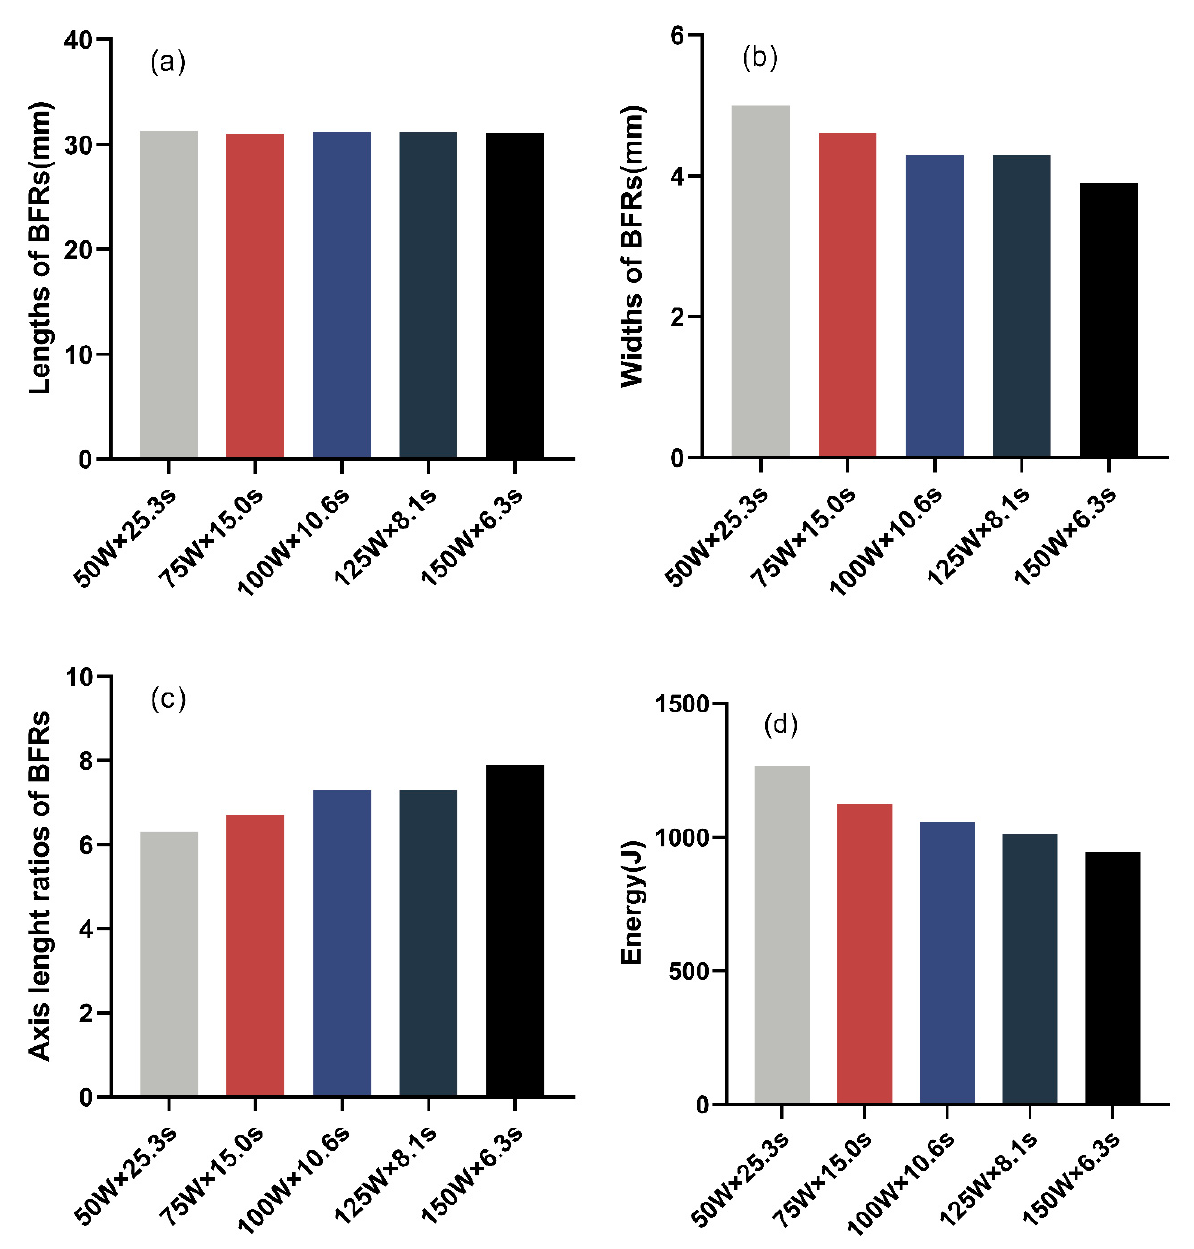
Figure 5. ( a ) Lengths, ( b ) widths, ( c ) axis length ratios of the BFRs, and ( d ) energy after ultrasonication with different combinations of acoustic power and time in a phantom simulation.